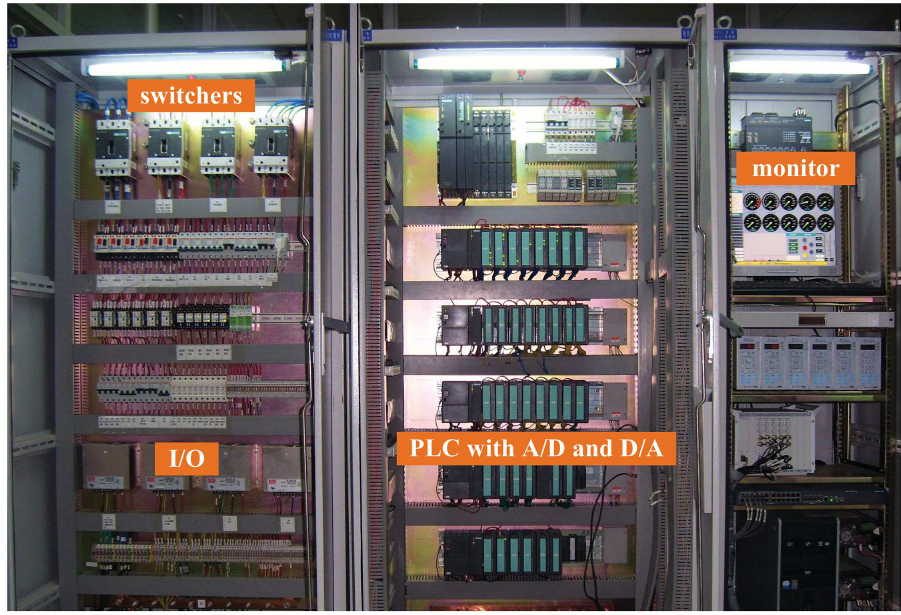
Fig 11. HIL system: DEC system.